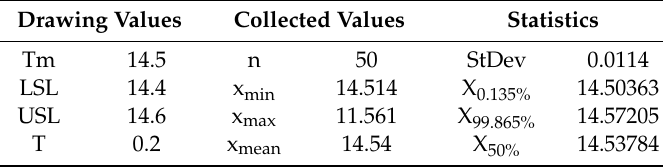
Table 6. Machine capability analysis for the D